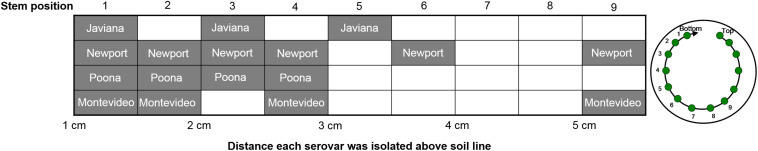
Endophytic recovery of S. enterica serovars and the distance traveled into the vascular stem tissue from soil inoculated with a five-strain cocktail (S. Javiana, Newport, Poona, Montevideo, and Typhimurium) at ca 8.3 log10 CFU/root zone. All stems derived from inoculated soil in the experimental group were harvested aseptically at ca. 1 cm above the soil line, sterilized, cut into ca. 0.5 cm segments and screened for endophytic populations of Salmonella. Molecular serotyping was used to determine the serovar of isolated colonies for each Salmonella-positive stem segment. Serovar Typhimurium was not identified from any of the stem segments and therefore, is not included in this figure. Stem position 1 represents ca. 1.0–1.5 cm from soil line while position 9 is closest to the apical portion of the stem (ca. 5.0–5.5 cm from soil line).